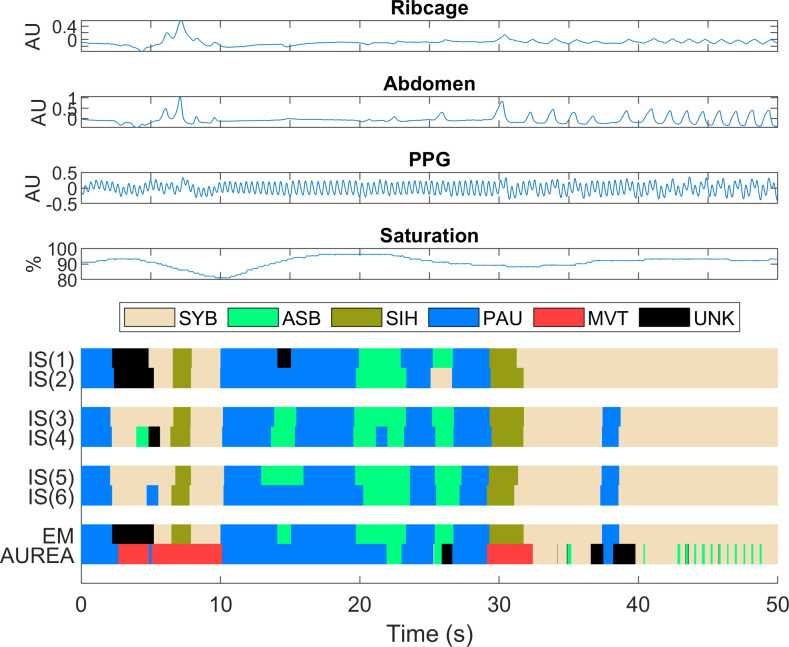
Representative signals.The raw signals of ribcage, abdomen, photoplethysmography (PPG), and saturation are shown. The data has been scored by twice by three scorers (IS) in independent instances. The breathing pattern classifications by expectation maximization (EM) and the automated unsupervised respiratory event analysis (AUREA) are also shown. Consecutive samples with identical breathing patterns are displayed as pattern segments. Both intra- and inter- scorer variability is evident. AUREA classified the SIH pattern as MVT; located in segments at 7s and 30s. Fragmentation is evident in the data classified by AUREA between 43s and 50s. Pattern legend ASB = asynchrony, MVT = movement, PAU = pause, SIH = sigh, SYB = synchrony, UNK = unknown.